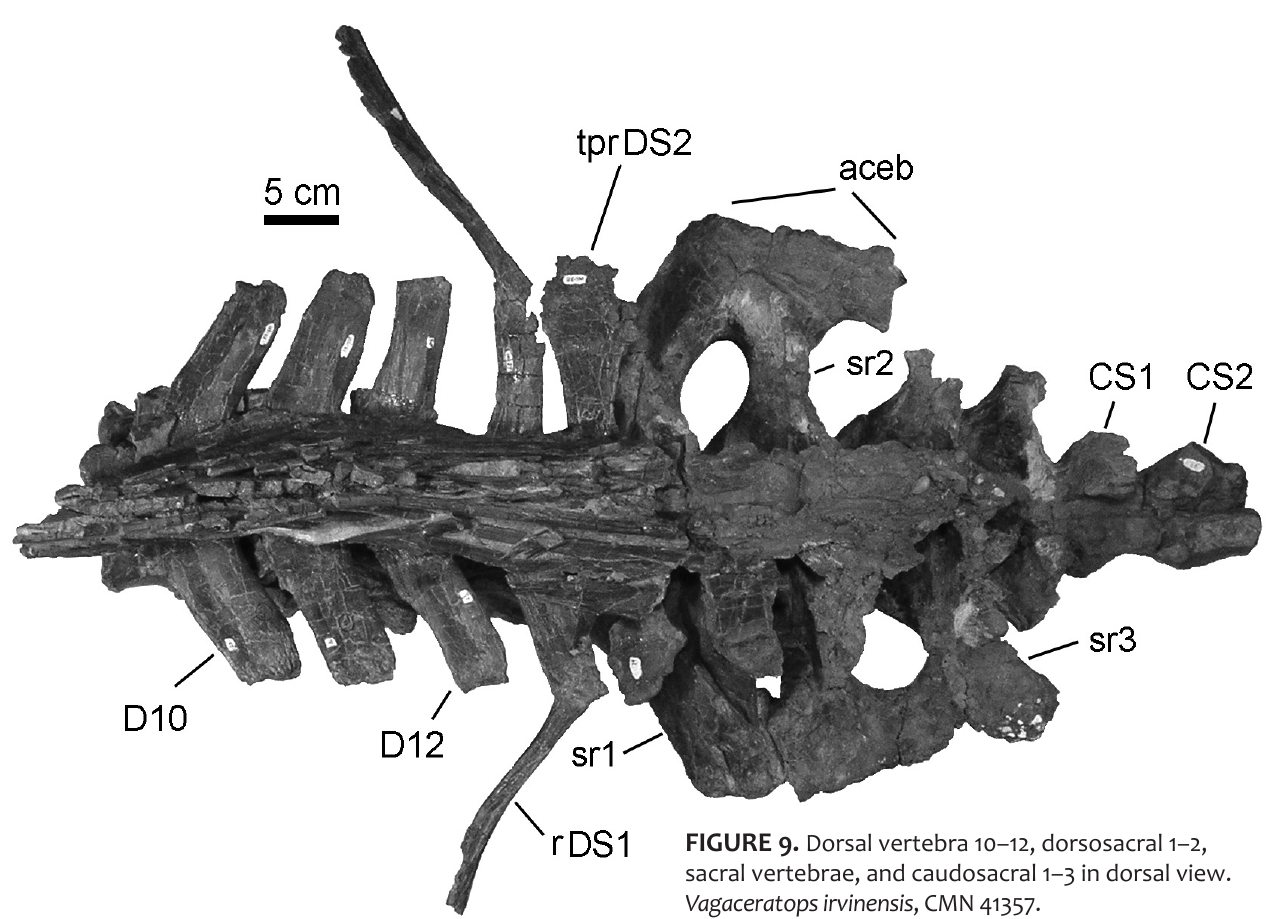
FIGURE 9. Dorsal vertebra 10–12, dorsosacral 1–2, sacral vertebrae, and caudosacral 1–3 in dorsal view. Vagaceratops irvinensis , CMN